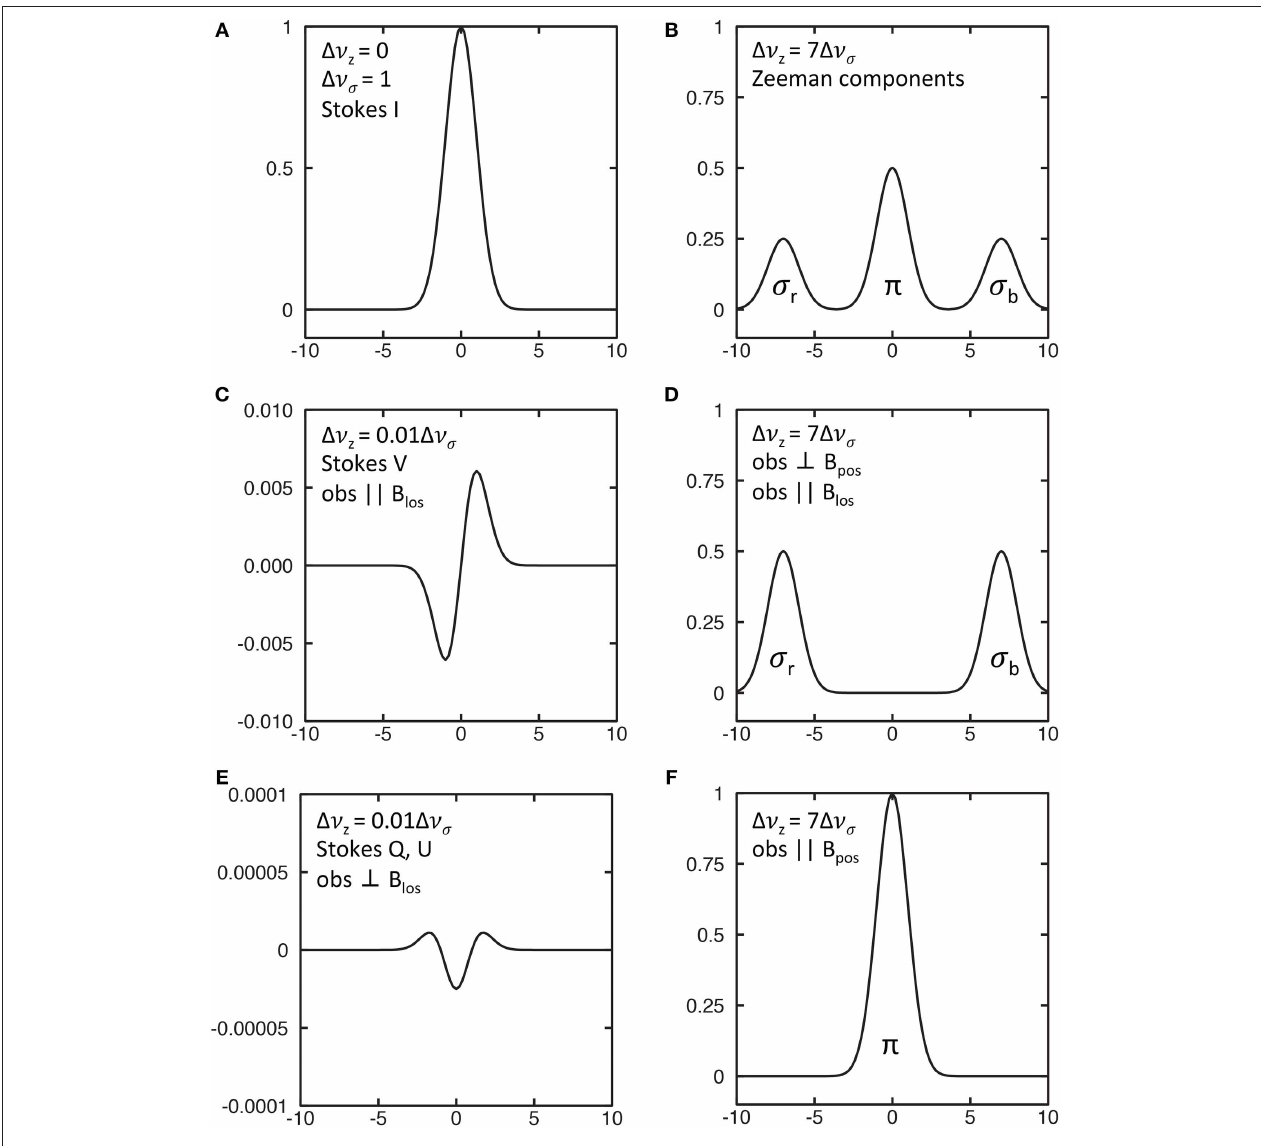
FIGURE 2 | Simulated Zeeman profiles for a Gaussian line profile. Units are relative with respect to peak of the Stokes I profile = 1. (A) Stokes I profile. (B) Zeeman-split components. (C) Stokes V profile for small Zeeman splitting. (D) : Stokes σ profile for large Zeeman splitting. (E) Stokes Q or U profiles for small Zeeman splitting. (F) Stokes π profile for large Zeeman